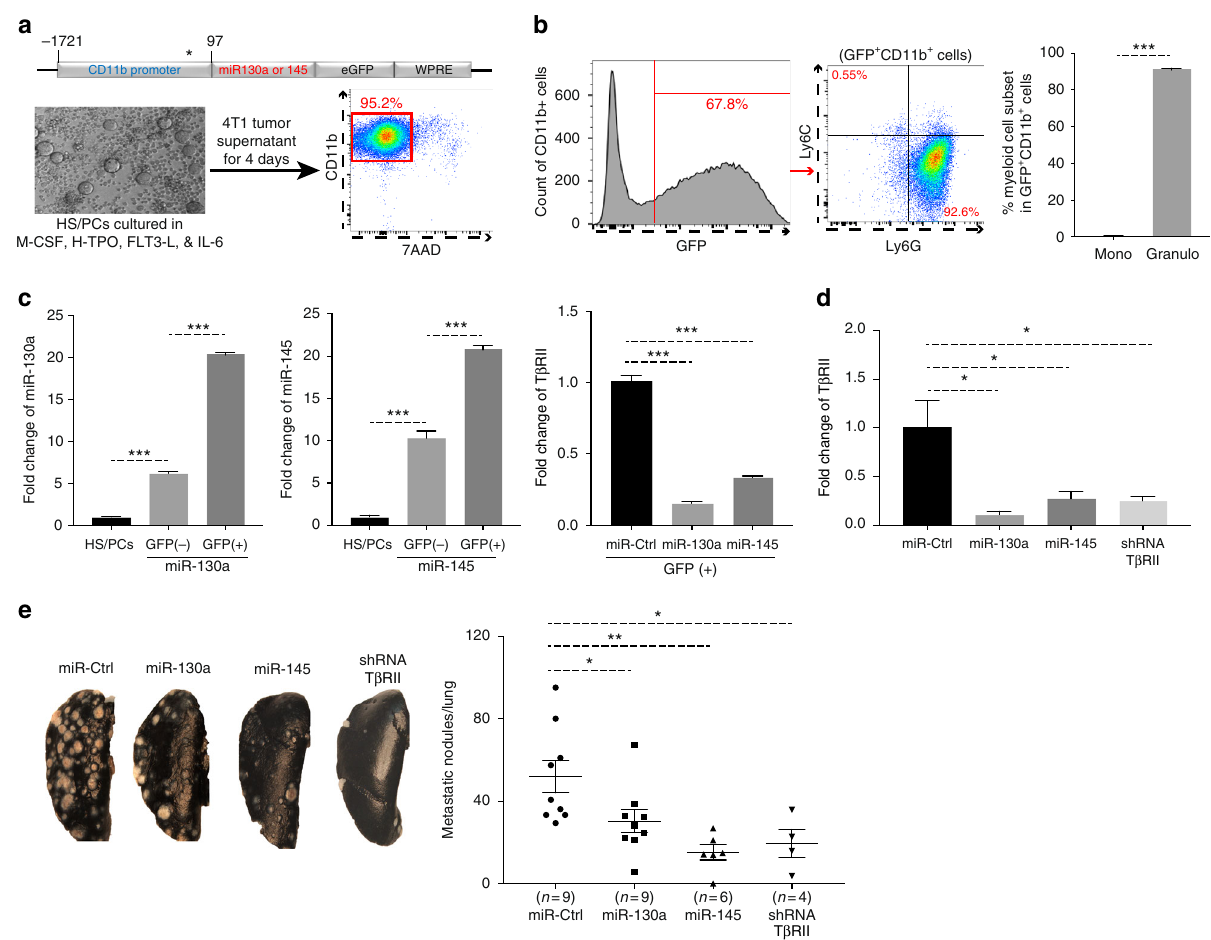
Fig. 2 Ectopic expression of miR-130a & miR-145 reduced tumor metastases. a Top panel: the construct of miR-130a or miR-145 expressions under control of a CD11b promoter, with GFP and WPRE (Woodchuck hepatitis virus posttranscriptional regulatory element) in 3 ′ -UTR. * indicates transcription starting site (TSS); numbers indicate CD11b promoter sequence relative to TSS. Lower panels: microscopy (left), fl ow cytometry analysis of CD11b + myeloid cells differentiated from HS/PCs with the lentiviral expression vector in the culture with 4T1 tumor supernatant (right). b fl ow cytometry of GFP expression in CD11b + myeloid cells (left), and CD11b + Ly6C + monocytic and CD11b + Ly6G + granulocytic subsets in GFP + myeloid cells (middle) with quantitative data (right). c Fold changes of miR-130a (left), and miR-145 (middle) as well as T β RII (right) in sorted GFP + and GFP – myeloid cells by qRT-PCR, with HS/PCs as a negative control. Data in ( b - c ) are from ex vivo culture as illustrated in ( a ). d T β RII fold changes by qRT-PCR from sorted peripheral blood Gr-1 + CD11b + myeloid cells of tumor-bearing mice that received miR-130a, miR-145, and T β RII shRNA-engineered bone marrow transplantation. e Lung metastasis of 4T1 cells in mice that received miR-engineered bone marrow transplantation as noted above. 4T1 cells were injected in MFP number 2 and metastatic nodules in the lung were assessed 28 days later ( n = 5 – 13 mice). The data are represented as mean±SEM, and Student ’ s t test was performed. * p < 0.05, ** p < 0.01, *** p < 0.001